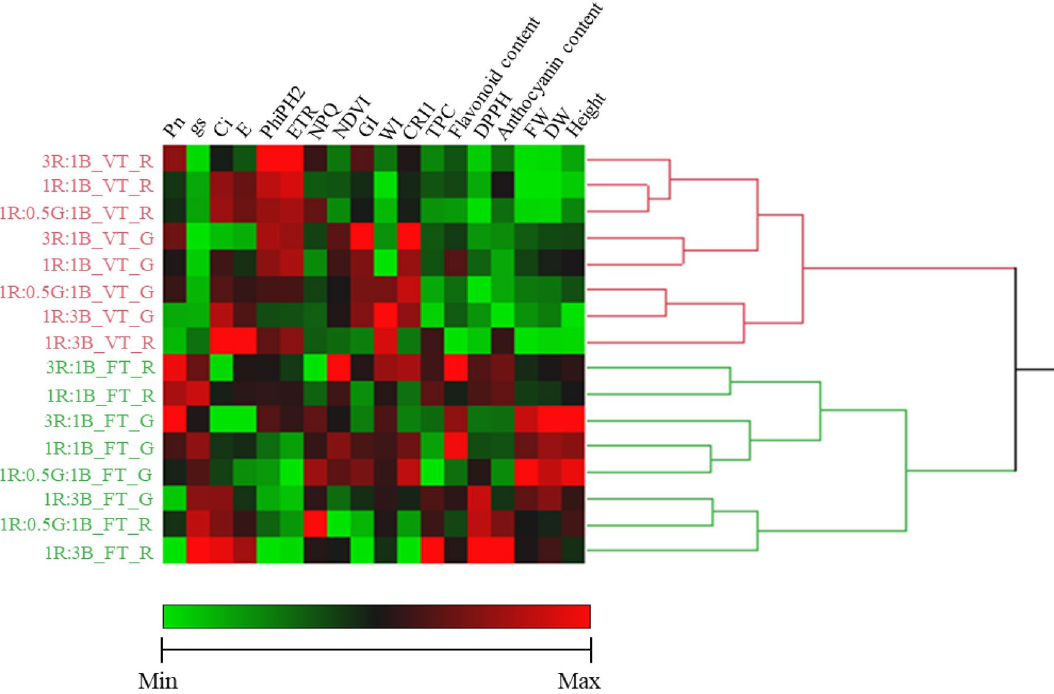
Figure 8. Heat map and clustering analysis of differential biomass accumulation, physiological response parameters and antioxidant capacity among different light treatments (3R:1B, 1R:1B, 2R:1G:2B, 1R:3B) in green (G) and red (R) holy basil at vegetative (VT) and flowering (FT) stages. R, G and B represent the red, green and blue llight spectra, respectively, and number before the letters stand for the ratio of each lighrt spectra.